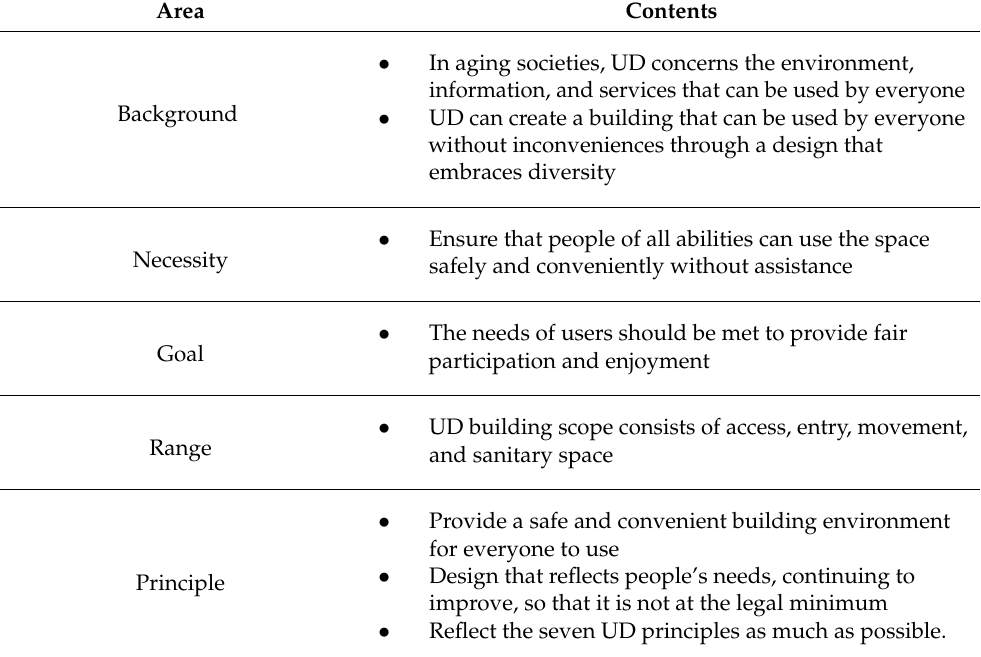
Table 3. Literature search